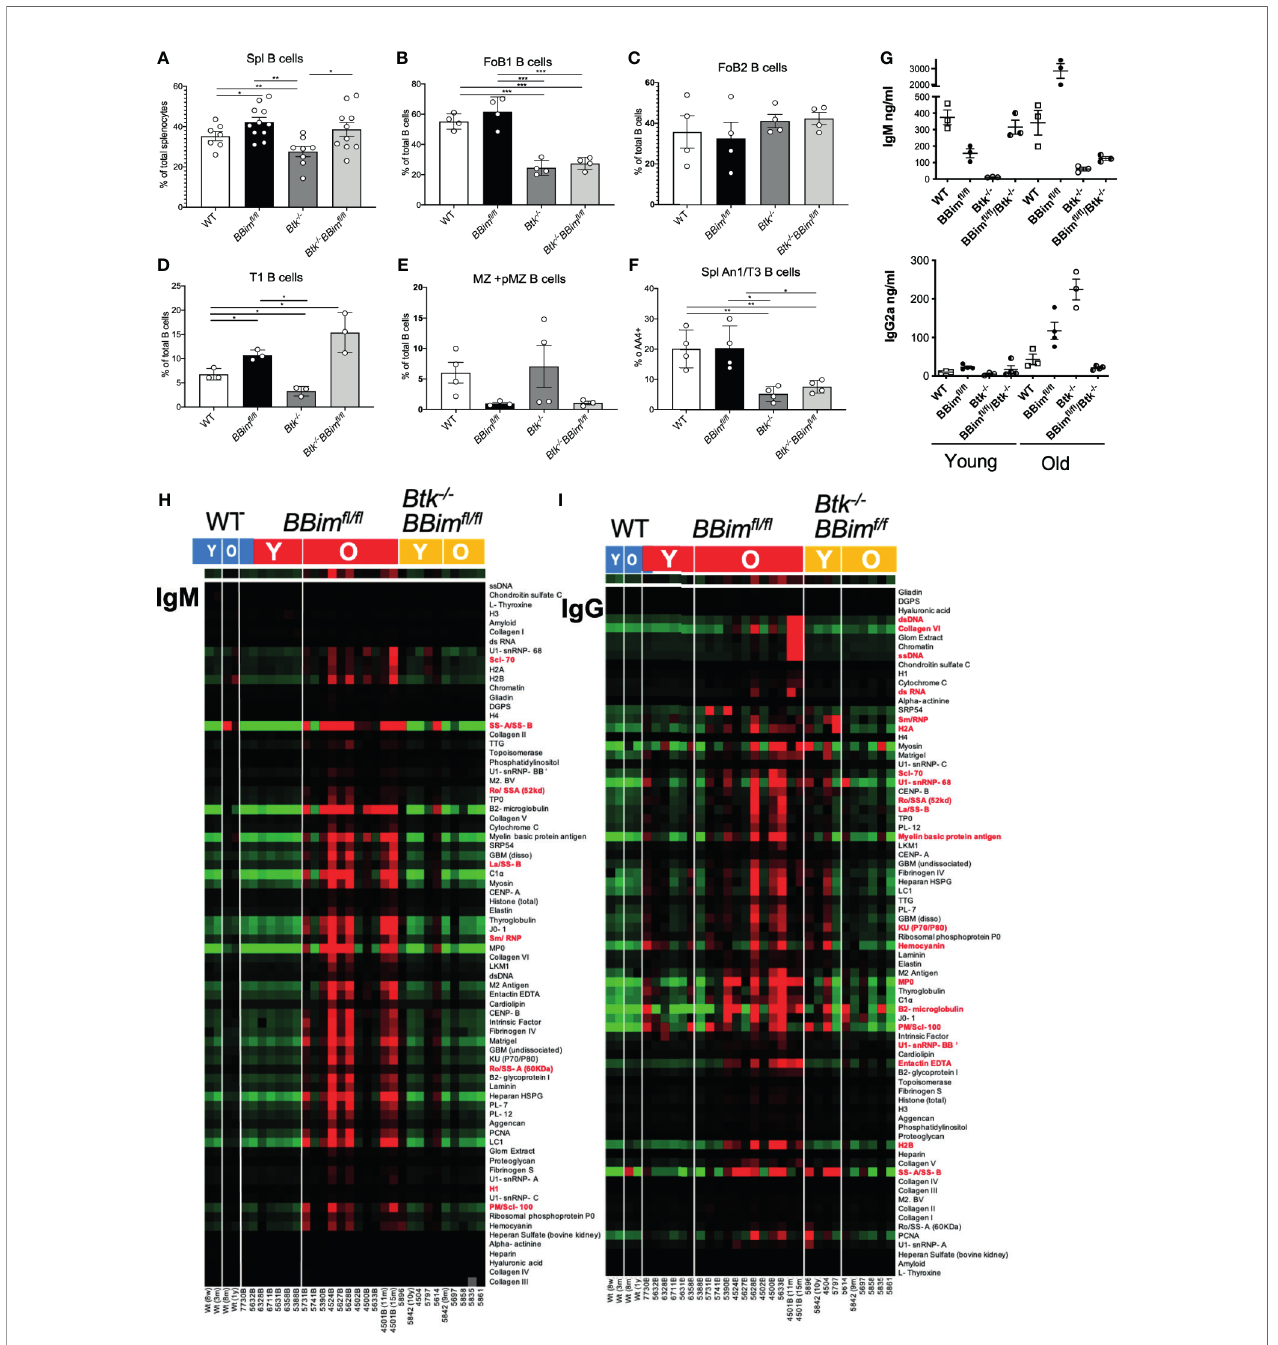
FIGURE 9 | Deletion of Btk in BBim fl / fl mice reduced symptoms of autoimmunity. (A) Graph displaying splenic B cell percentages in WT, BBim fl / fl , Btk -/- and Btk -/- BBim fl / fl mice. (B – F) Representative graphs comparing percentages of the listed B cells subpopulations in WT, BBim fl / fl , Btk -/- , and Btk -/- BBim fl / fl mice. (G) Basal IgM and switched IgG2a antibodies in the serum of young ( ≤ 12 weeks old) and old ( ≥ 12 weeks old) mice. (H, I) Heat map with clustering of autoAbs in the serum from WT (left), BBim fl / fl (middle) and Btk -/- BBim fl / fl (right) mice of indicated ages (H) IgM and (I) IgG autoAbs. *P ≤ 0.05, **P ≤ 0.01, ***P ≤ 0.001, calculated by Students